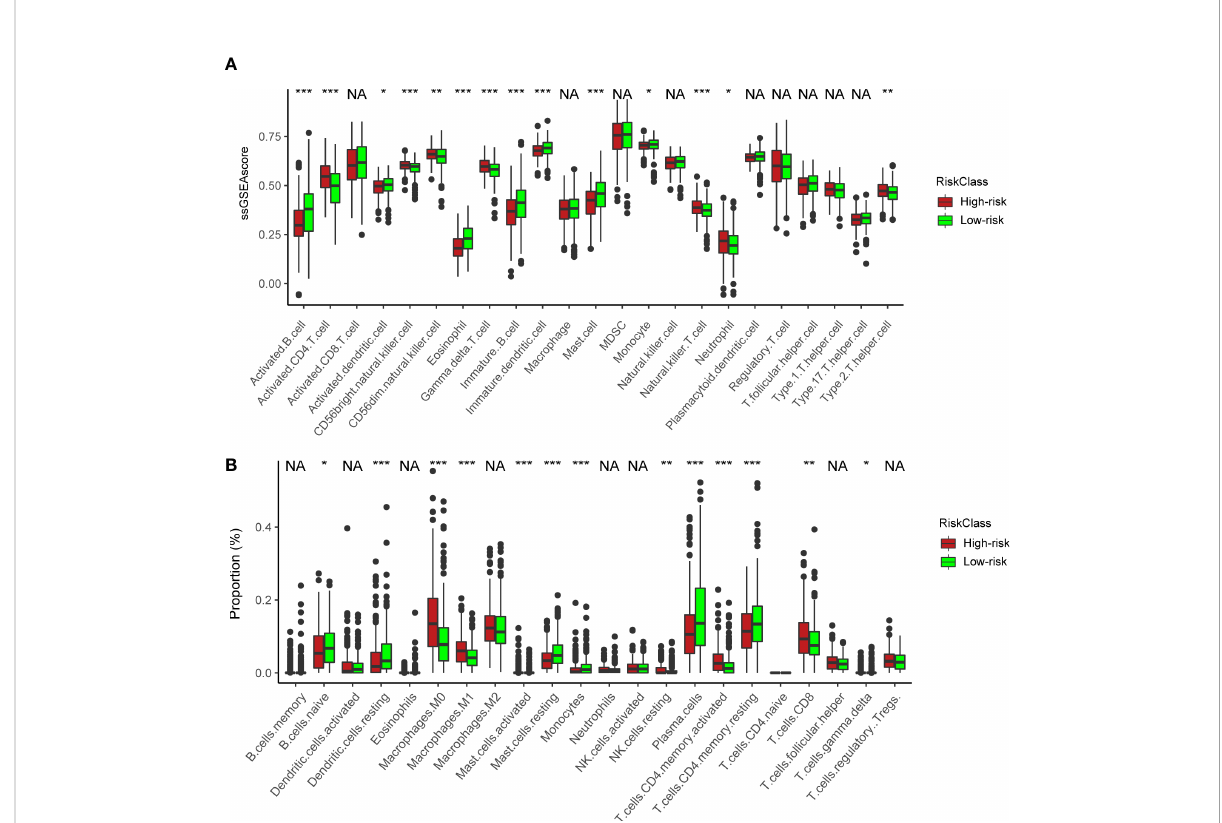
FIGURE 6 Immune characteristics between the high- and low-risk groups. (A) ssGSEA of immune cells in high- and low-risk groups. The statistical difference of three clusters was compared by the Kruskal – Wallis H test. *P < 0.05; **P < 0.01; ***P < 0.001. (B) Boxplot shows the proportion of immune cells calculated by CIBERSORT analysis. The statistical difference of three clusters was compared by the Kruskal – Wallis H test. *P < 0.05; **P < 0.01; ***P < 0.001; NA, no difference in statistics.